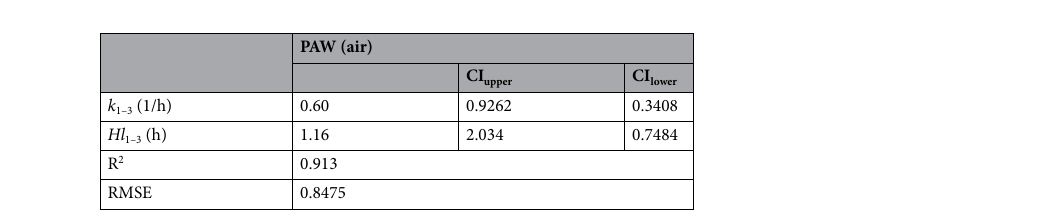
Table 4. Inactivation rate constant (k) and half-life (Hl) of E. coli exposed to PAW (air) replicates 1–3 obtained from the exponential decay equation. Goodness of fit represented by R squared (R 2 ) value. Profile likelihood of each value demonstrated using 95% Confidence Interval